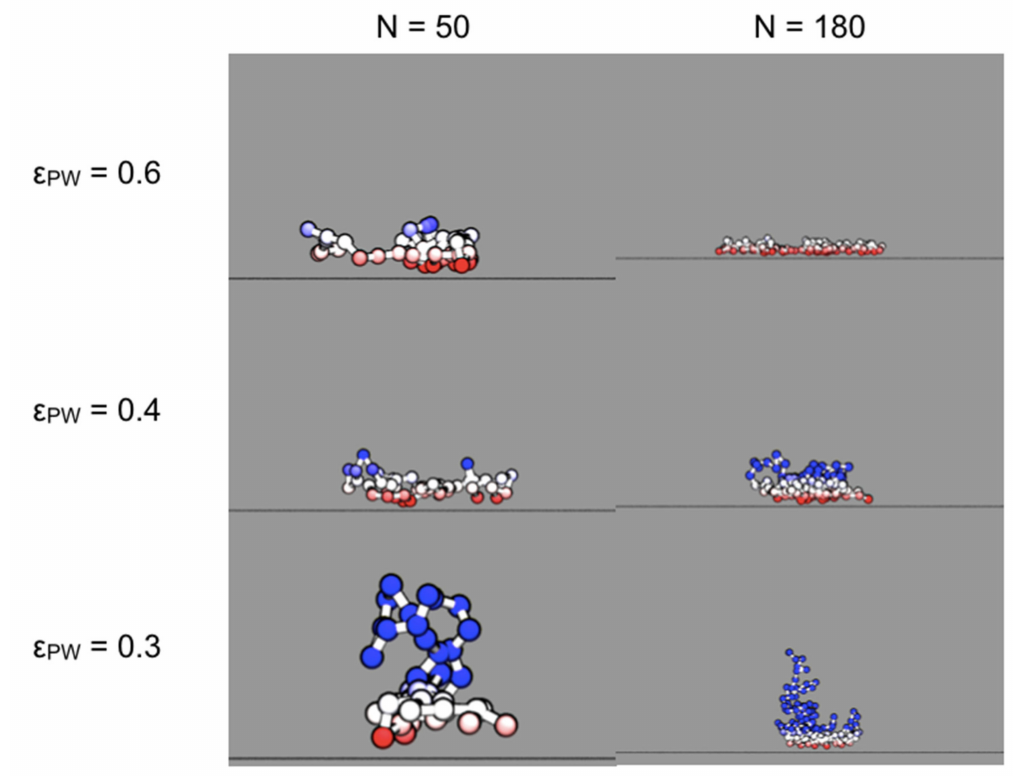
Figure 6. Snapshots of chains with three di ff erent polymer–wall interaction energies ε PW and of two di ff erent lengths. These chains did not have excluded volume interactions. Beads are colored on a scale of red (adsorbed) to blue (desorbed), where z ≤ 0.4 nm is red, z = 0.7 nm is white, z ≥ 1 nm is blue, and intermediate colors are blended. The units of ε PW are kJ /